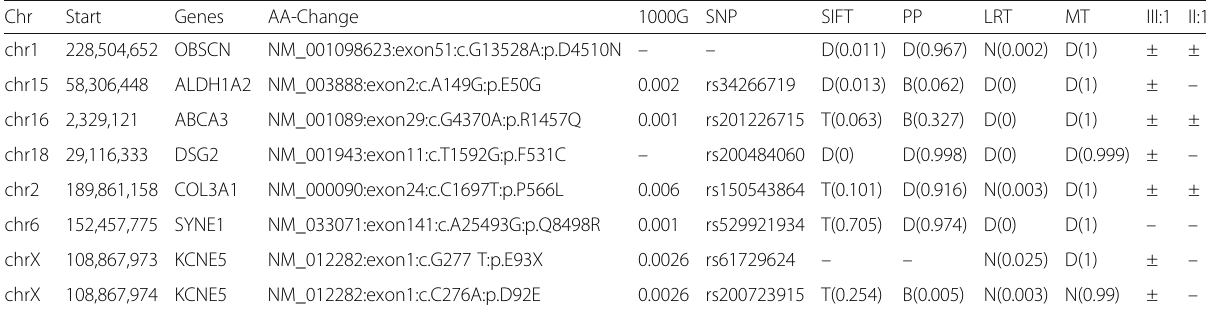
Table 2 Potential and pathogenic genes identified by whole exome sequencing and predisposed to cardiomyopathies and